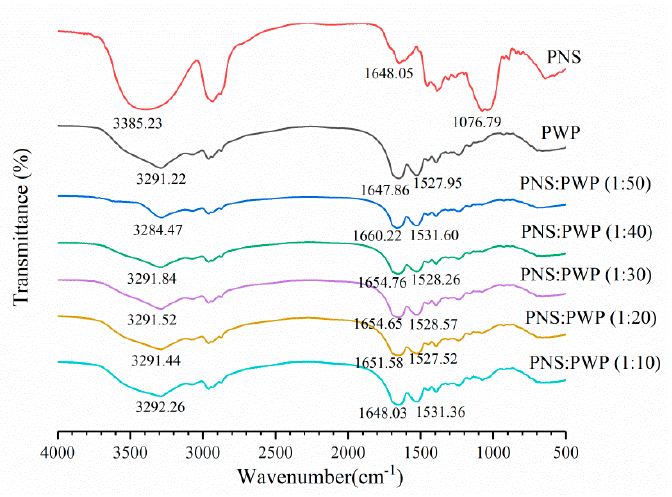
Figure 5. FTIR spectra of PWP, PNS and the mass ratio of PNS to PWP at 1:50, 1:40, 1:30, 1:20 and